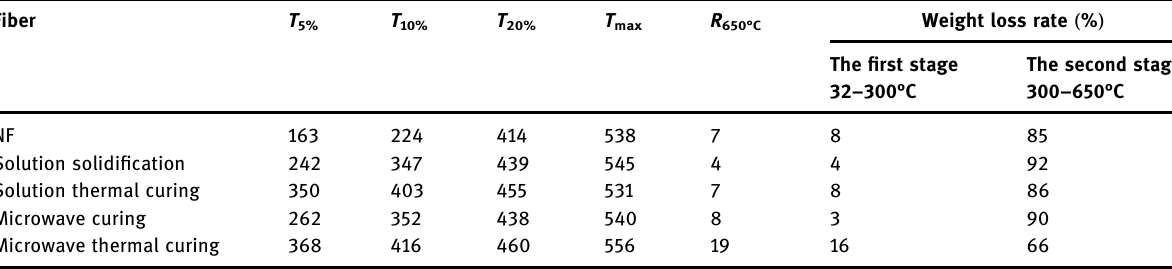
Table 4: TGA data of di ff erent phenolic fi bers in air atmosphere